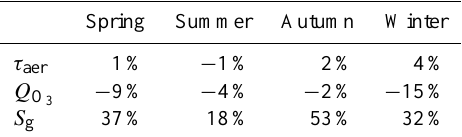
lead to changes in S ery between 18 % (in summer) and 53 % (in autumn). The influence of the variation in Q O much smaller. Changes in the variation of Q O to negative changes in S ery (from − 2 % in summer to − 15 % in winter), whereas the influence of a change in variation of τ aer varies from a negative value ( − 1 % change in S ery ) in summer to positive values in the other seasons, with a maxi- mum of 4 % in winter (Table 10). τ aer and S g have their